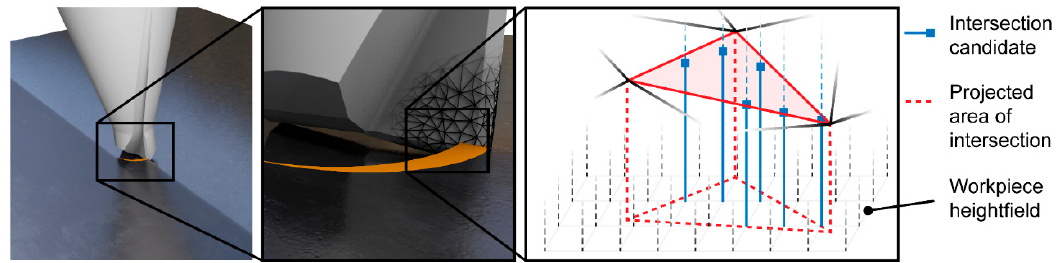
Figure 8. Bounding-box test for determining potential intersection candidates.